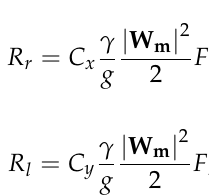
Figure 2. The breakdown drawing of the velocity triangle.